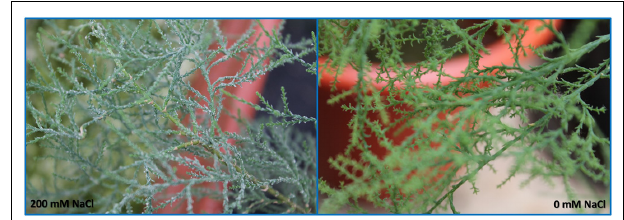
FIGURE 1 | Tamarix gallica leaves of individuals subjected to 200 and 0 mM NaCl Photo by B. Duarte (2012). Plants were originally collected in Tunisia and transplanted to the Centre of Oceanography greenhouse, where they were subjected to different salinity levels.